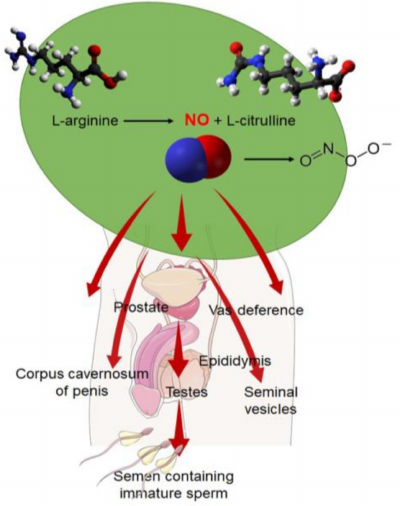
Figure 1. Sources of reactive nitrogen species (RNS). Illustration of the various locations of RNS throughout the male reproductive system. Specifically, these sources can be broken down by structure and various cell types, as shown above. NO—nitic oxide, O 2 —oxygen, ONO 2